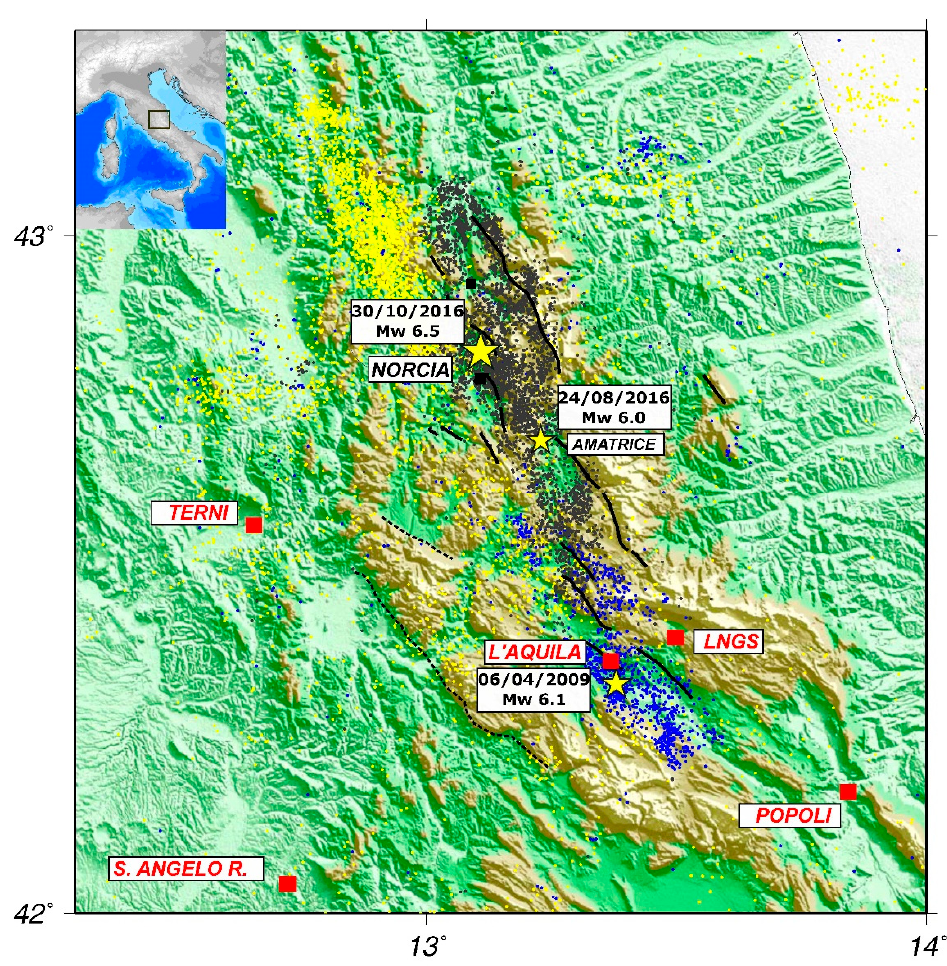
Figure 1. Sketch map of central Italy showing the absolute gravity/GNSS network, including five stations (squares and labels in red), measured in 2018 (date of installation), 2019, and 2020. The epicenters of seismic events with Mw ≥ 6.0 (yellow stars) and the background seismicity from INGV databank (M ≥ 2.5, max depth 30 km), for the periods 1 January 1985–31 December 2008 (yellow dots), 1 January 2009–23 August 2016 (blue dots), and 24 August 2016–3 January 2019 (black dots), are also indicated.